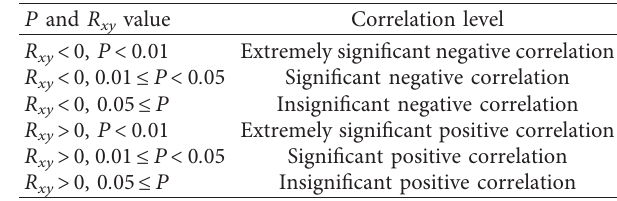
Table 2: Pearson correlation coefficient and corresponding cor- relation